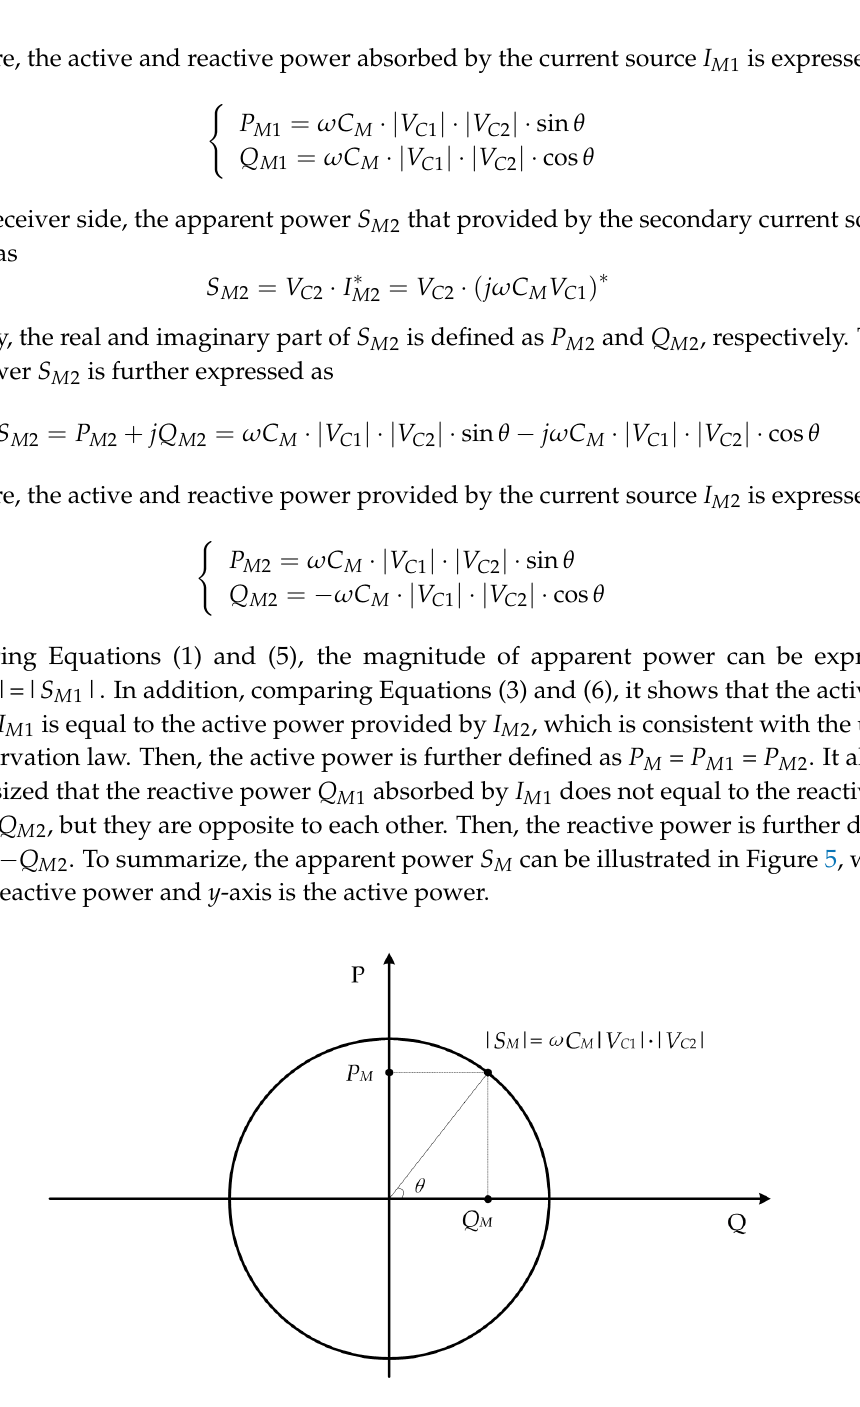
Figure 5. The apparent power S M transferred to the secondary side.